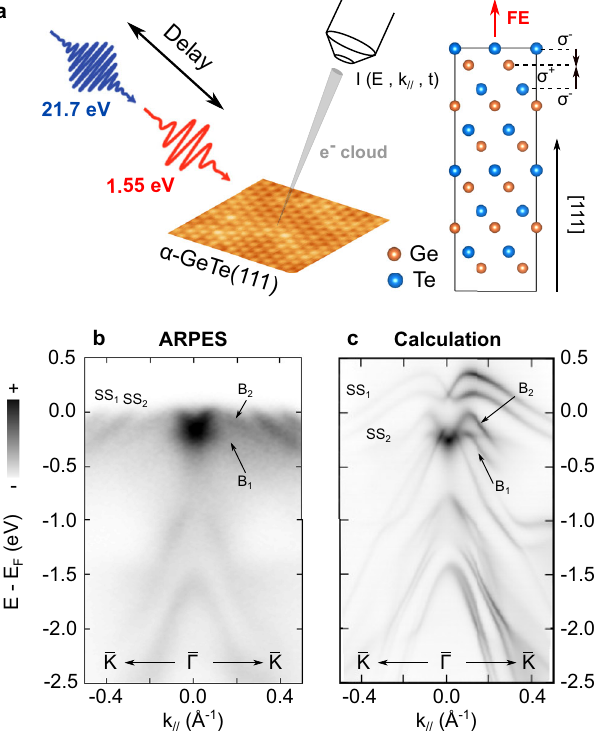
Fig. 1 | tr-ARPES con fi guration and static ARPES characterization. a tr-ARPES experiment using 21.7 eV probe and 1.55 eV pump pulses (left), and surface struc- ture of α -GeTe along the [111] crystallographic direction with Te termination and shortsurface bonds(right).Interatomicdipoles (blackarrows)due to negative ( σ − ) and positive ( σ + ) netchargesgive rise to a netoutward FEpolarization(redarrow). b StaticARPESspectrumalongthe (cid:1) K (cid:1) (cid:1) Γ (cid:1) (cid:1) K high-symmetrydirection(seesecond derivative in Supplementary Fig. 1) and c corresponding one-step model of pho- toemission calculations for a Te-terminated surface of α -GeTe(111) with short surface bonds.